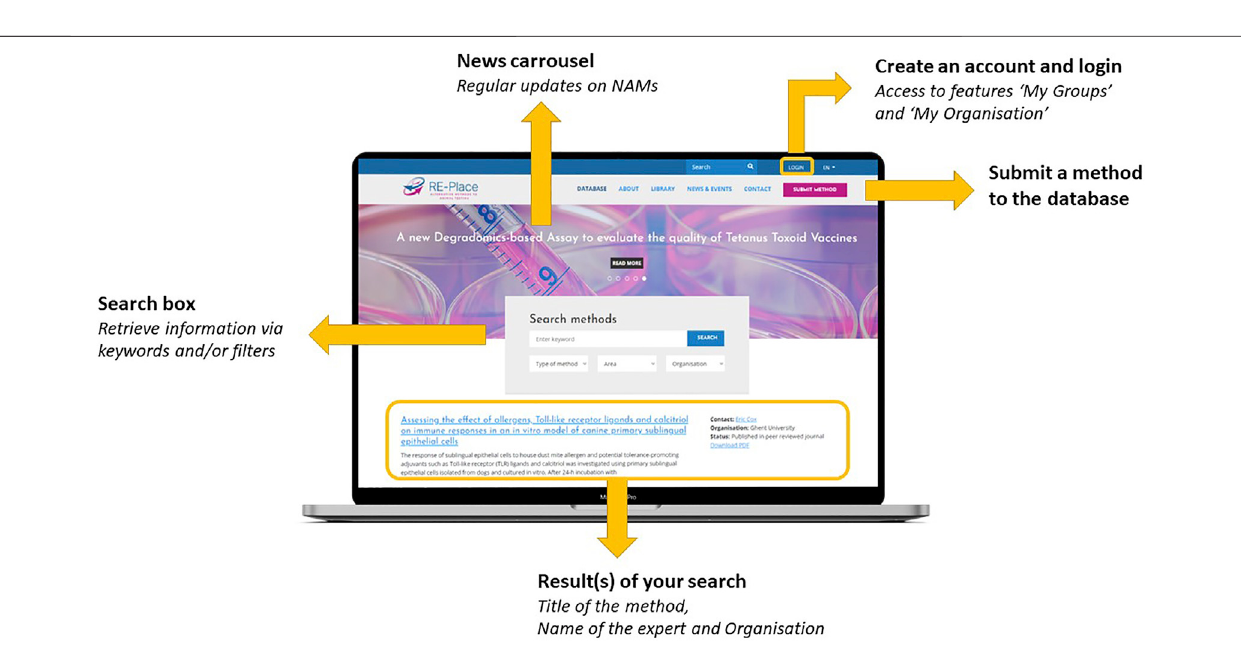
FIGURE 2 | The RE-Place platform with its